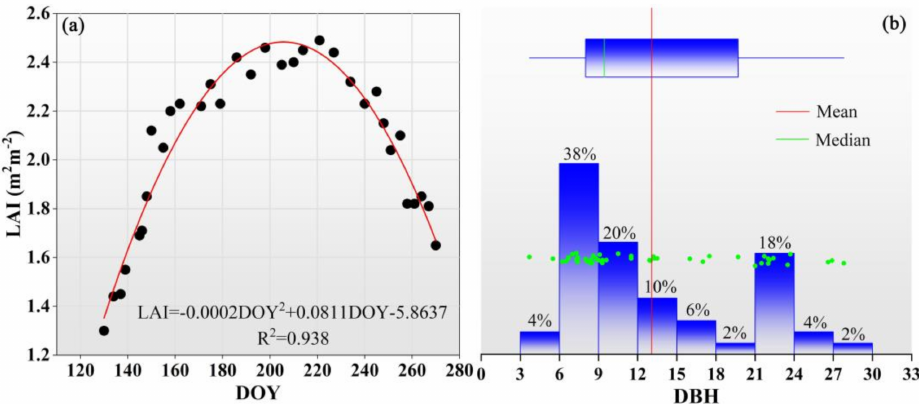
Figure 2. Plot showing the ( a ) LAI variations in the study period; ( b ) frequency distribution of the DBH in study sample plot.